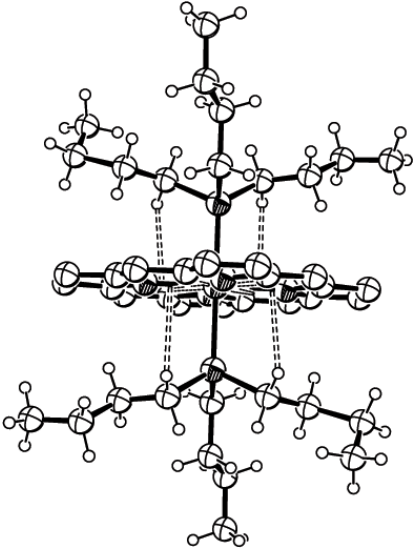
Figure 2. Crystal structure of KACGIE. Dashed lines represent C − H ··· π interactions. Some of atoms have been omitted for clarity. Coordinates are taken from